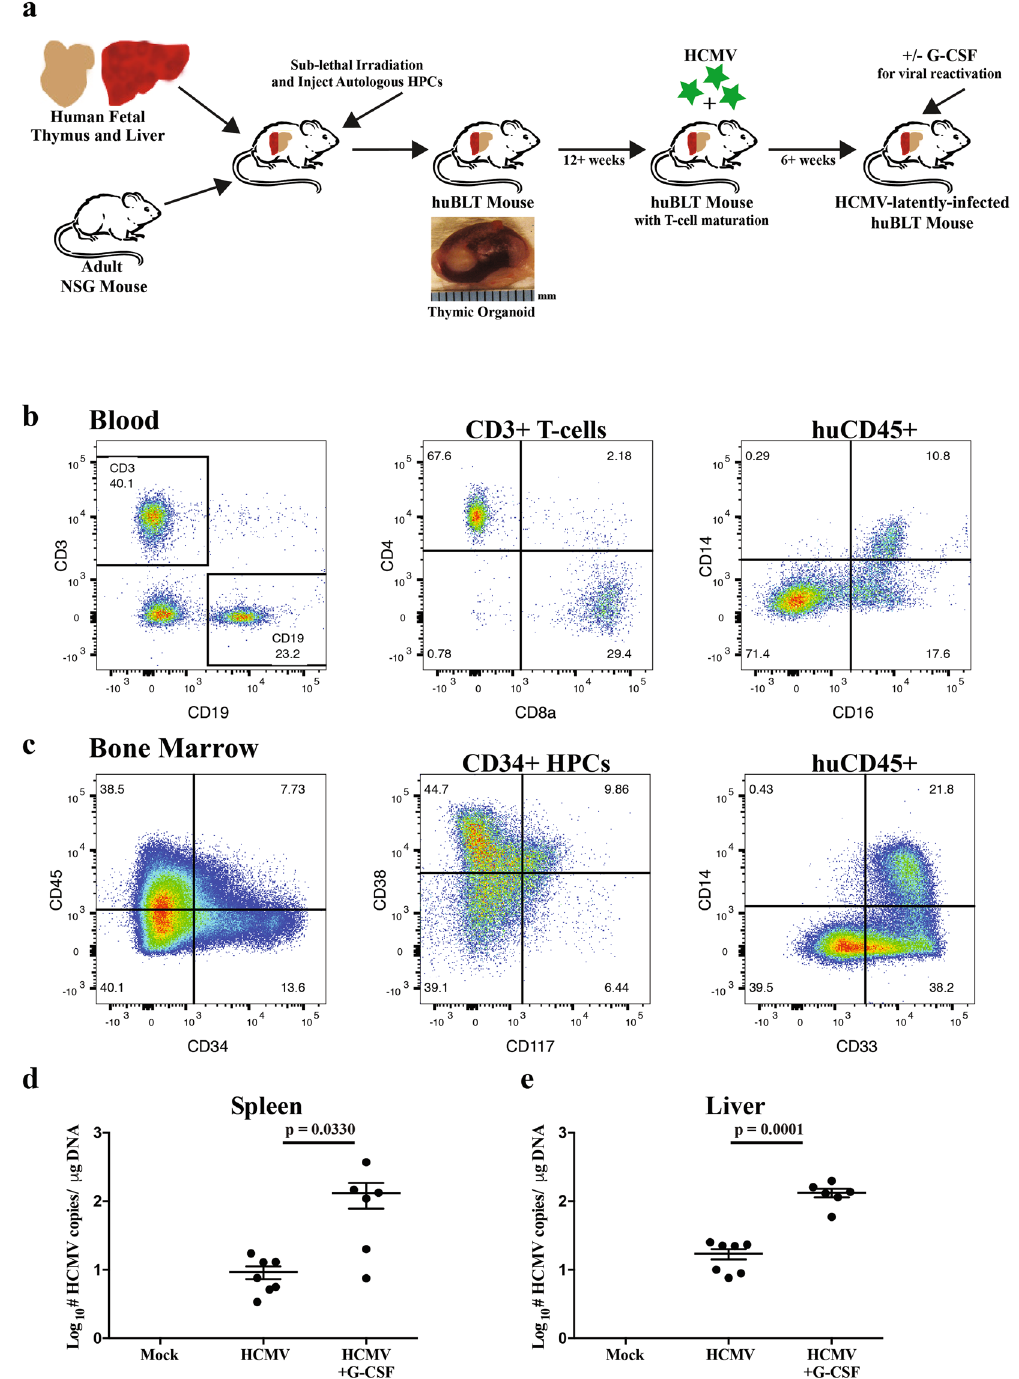
Figure 1. Generation of humanized BLT-NSG (huBLT) mice and human cell reconstitution. ( a ) Bone marrow- Liver-Thymus (huBLT) mice were generated by transplantation of human fetal liver and thymus under the kidney capsule of an adult NSG mouse. Post-surgical transplant, mice were sublethally irradiated (200 cGy) and intravenously injected with human CD34 + hematopoietic progenitor cells (HPCs) isolated from autologous fetal liver tissue. Post T-cell reconstitution (12–16 weeks following engraftment), huBLT mice were infected with HCMV by intraperitoneal (IP) injection of HCMV-infected fibroblasts or Mock infected by IP injection of uninfected fibroblasts. Beginning at 6 weeks post-infection huBLT mice are screened for HCMV-specific immune responses. Latently-infected huBLT mice are treated with G-CSF to induce viral reactivation at 8 weeks post-infection. ( b ) Human cell reconstitution was monitored by flow cytometry analysis of peripheral blood for the percentage of human CD45 + leukocytes (out of total human plus murine CD45 + leukocytes) beginning at 8 weeks post-humanization. Human CD45 + leukocytes can be further analyzed using human specific antibodies, including assessment of CD3 + T-cells and CD19 + B-cells (panel 1) and CD3 + T-cells further discriminated into CD4 and CD8 subsets (panel 2). In addition, monocyte subsets, as characterized by